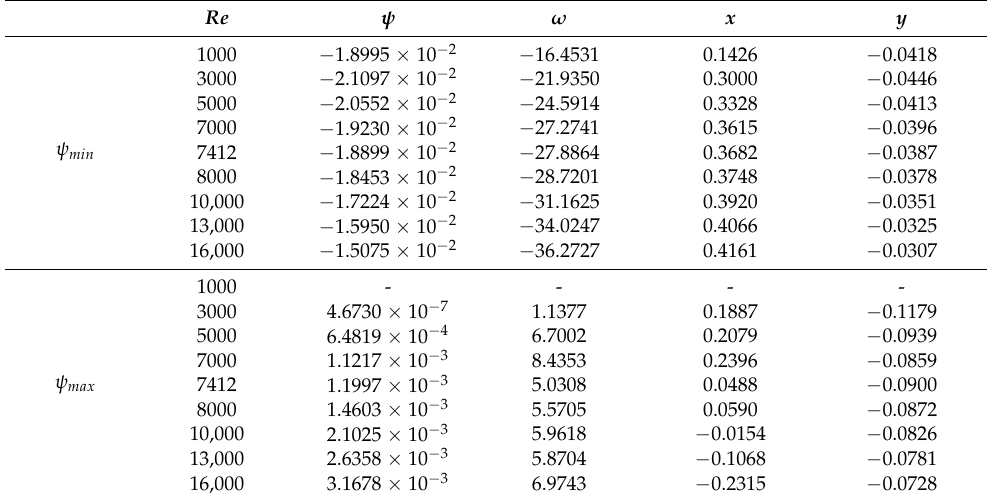
Table 5. Minimum and maximum streamfunction values in the 1st solution, corresponding vorticity values and ( x , y ) locations for D = 0.26 aspect